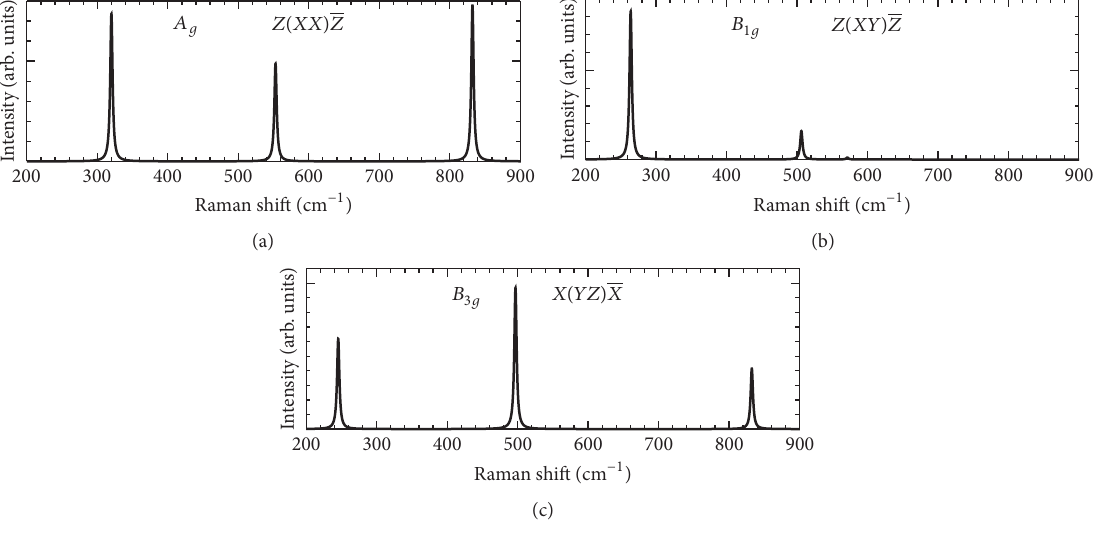
Figure 6: Backscattering Raman spectra of Ti 3 B 4 crystal calculated at scattering geometries (a) 𝑍(𝑋𝑋)𝑍 , (b) 𝑍(𝑋𝑌)𝑍 , and (c) 𝑋(𝑌𝑍)𝑋 . Spectra are simulated at 300 K and with laser excitation wavelength of 532 nm. Peaks are represented by Lorentzian functions with artificial FWHMs of 2 cm −1